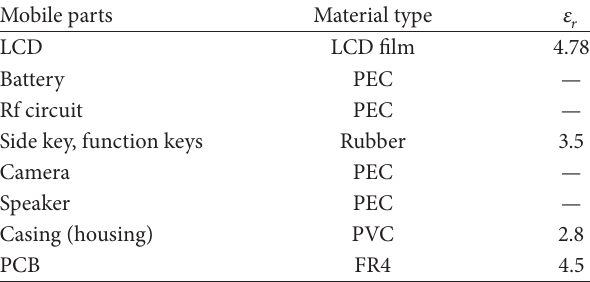
Table 3: Characteristics of the mobile